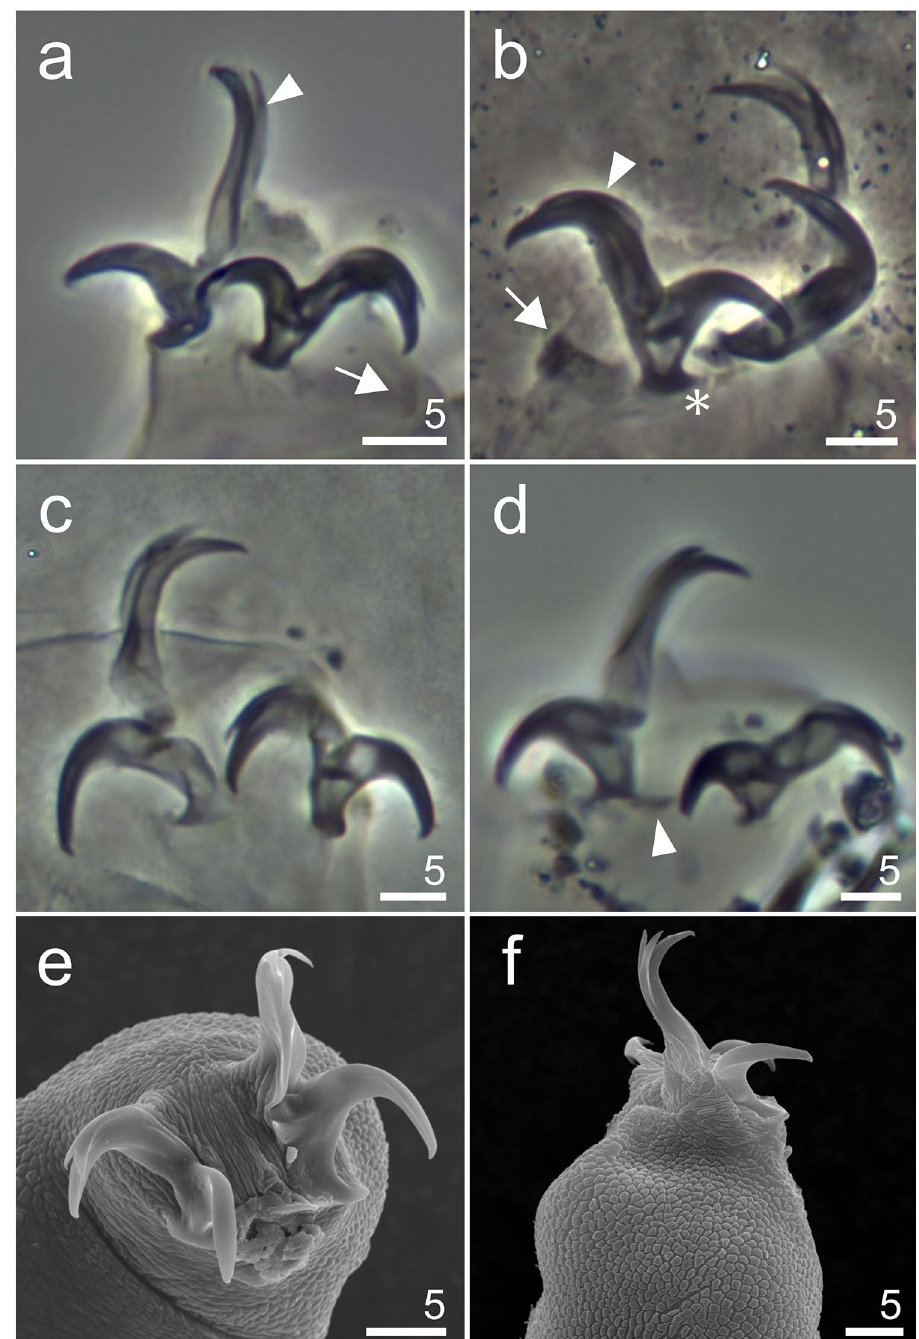
Figure 6. Hypsibius nivalis sp. nov., claws: ( a ) claws I, arrowheads indicates accessory points, arrow indicates cuticular bar, paratype (PCM), ( b ) claws II, arrowheads indicates accessory points, arrow indicates cuticular bar, asterix indicates pseudolunules, paratype (PCM), ( c ) claw III, paratype (PCM), ( d ) claws IV, arrowhead indicates small cuticular bar, holotype (PCM), ( e ) claws IV, details of claws and claw bases, paratype (SEM), ( f ) leg III, external claw, paratype